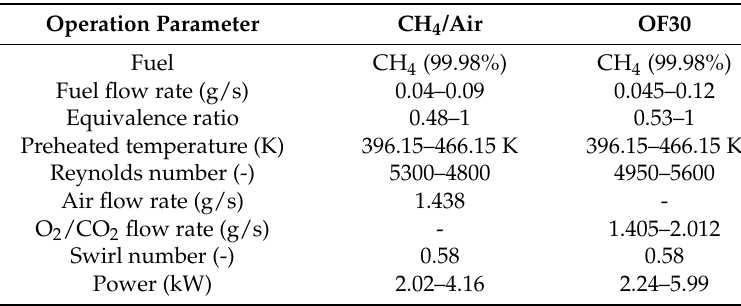
Table 1. Operating conditions for experiments.